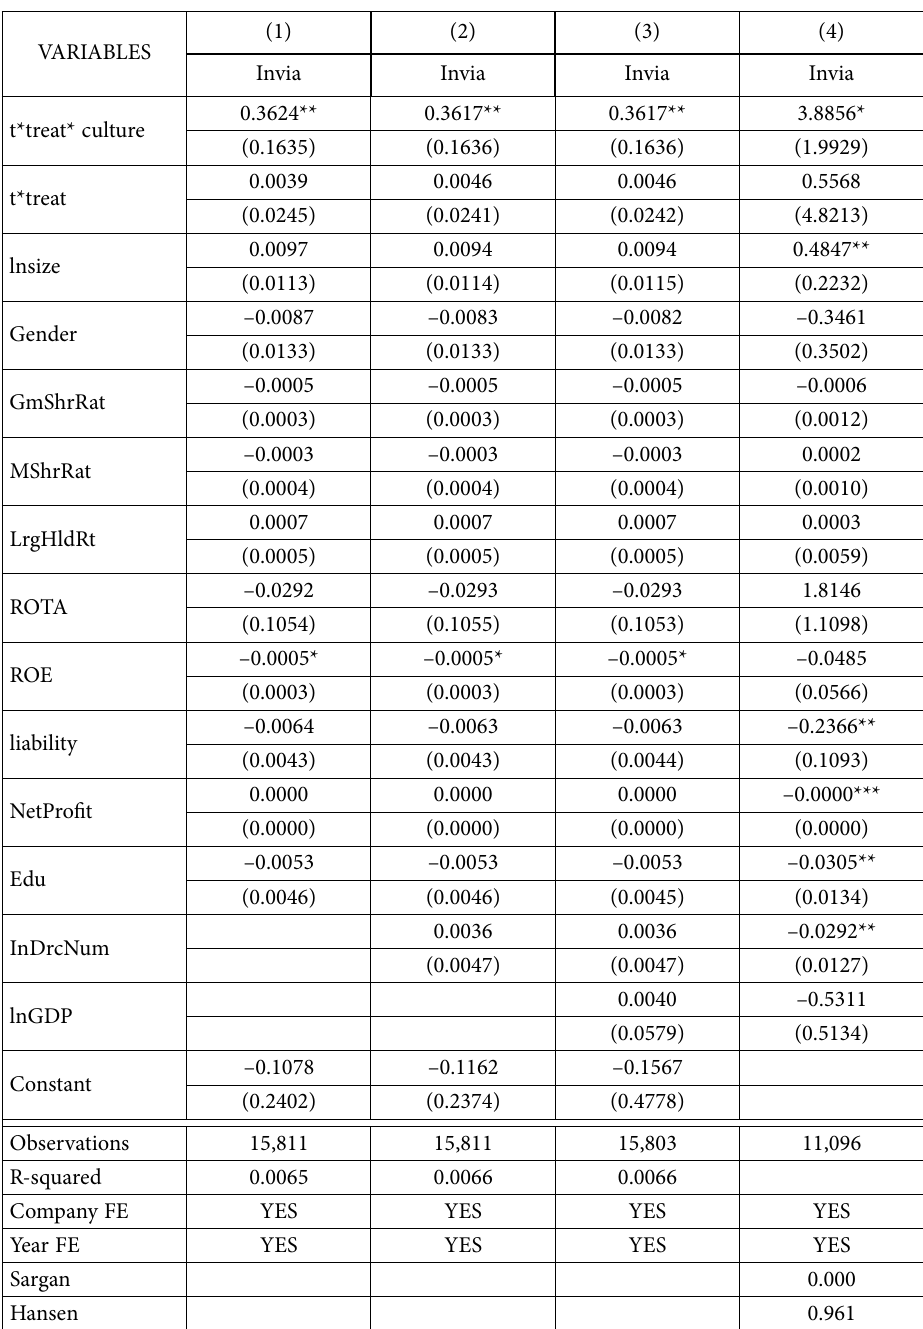
Table 4. Omitted variables and